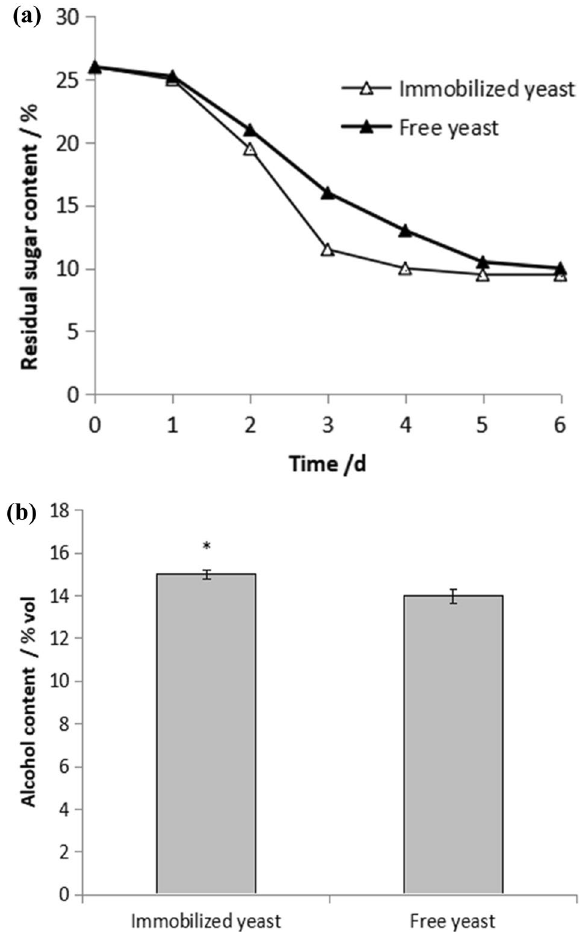
Figure 2. ( a ) Comparison of residual sugar content change between free yeast and immobilized yeast. ( b ) Comparison of alcohol content between free yeast and immobilized